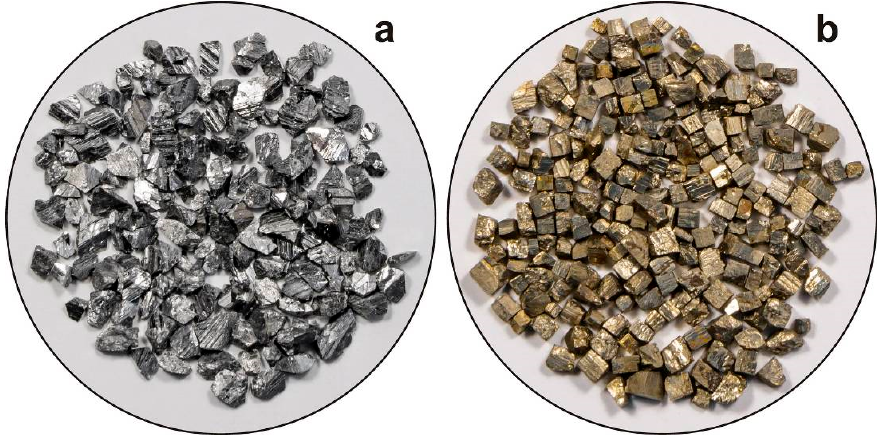
Figure 3. Monomineral fractions: ( a) arsenopyrite, ( b ) pyrite.